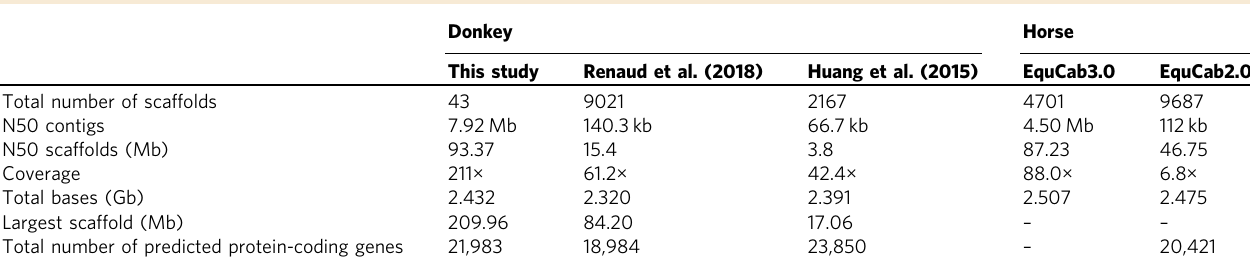
Table 1 Quality metrics for the donkey genome assembly generated in the current work and for other donkey and horse genome assemblies published in previous studies. Donkey